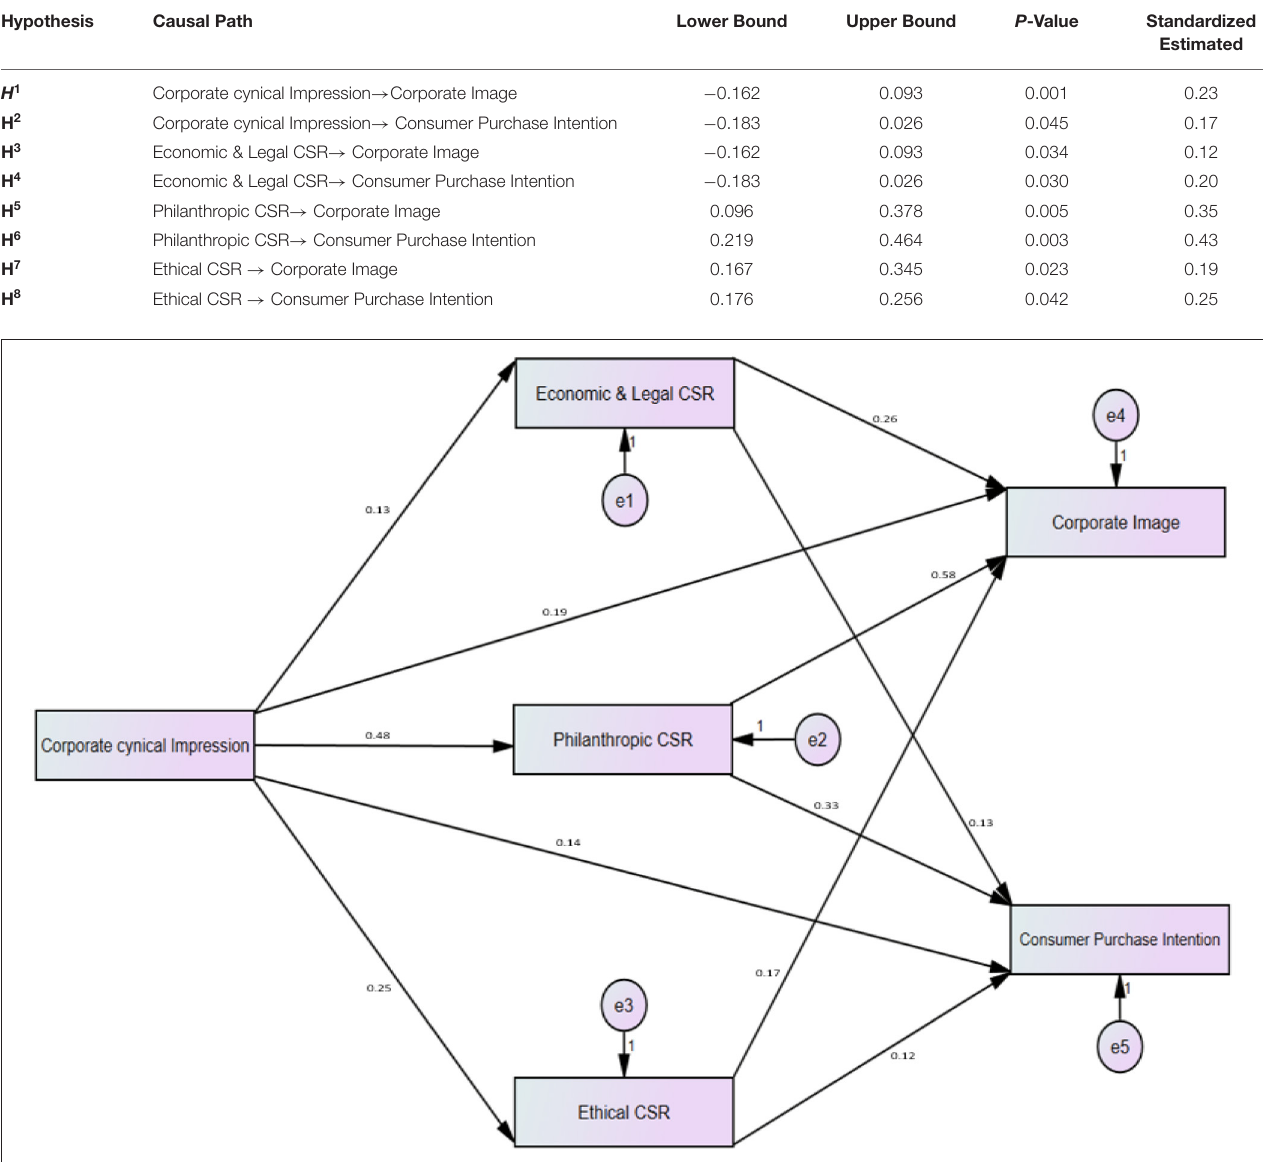
FIGURE 3 | Indirect direct effects of path